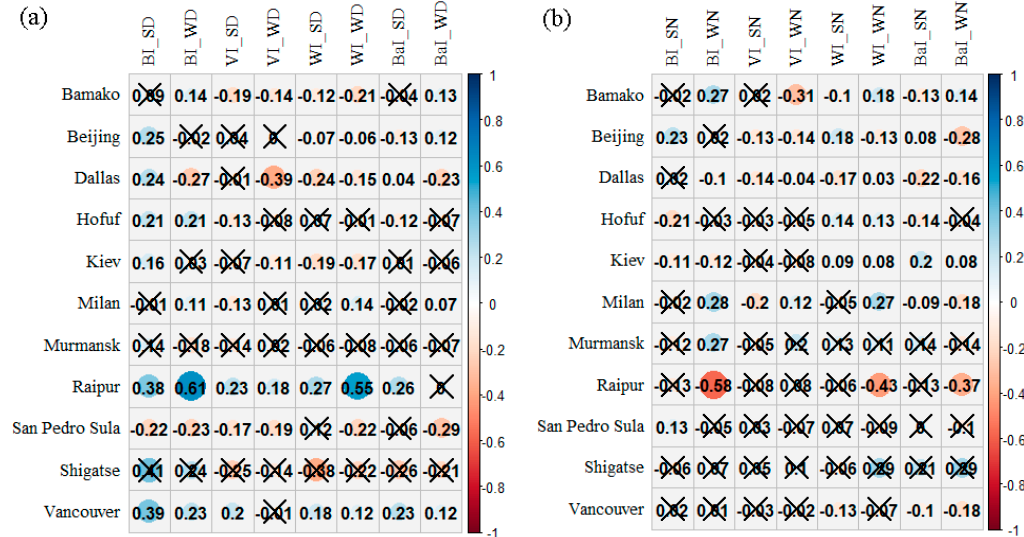
Figure 5. Partial correlation coefficients and significance levels between land surface temperatures and the indices of building, vegetation, water body and bare soil in eleven cities in typical global climatic zones during the daytime ( a ) and nighttime ( b ) in the summer and winter. These optimal remote sensing indices were determined based on Table 4. BI, VI, WI and BaI represent the index of building, vegetation, water and bare soil, respectively. SD, WD, SN and WN refer to the summer daytime, winter daytime, summer night and winter night, respectively. The symbol “×” represents the fact that the partial correlation coefficients have not passed the significance level of 0.05.